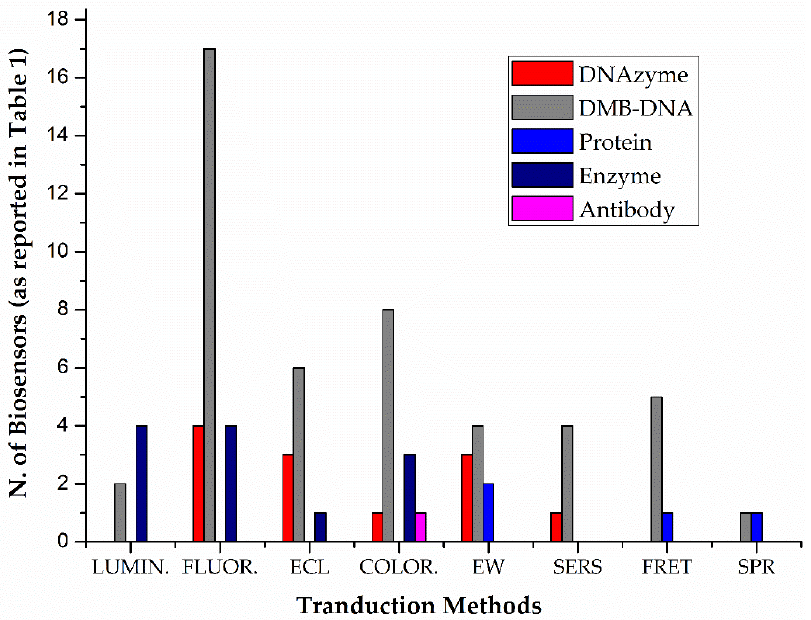
Figure 2. Distribution of biorecognition elements exploited in recently reported sensors for HM detection in real samples, as classified in Table 1.